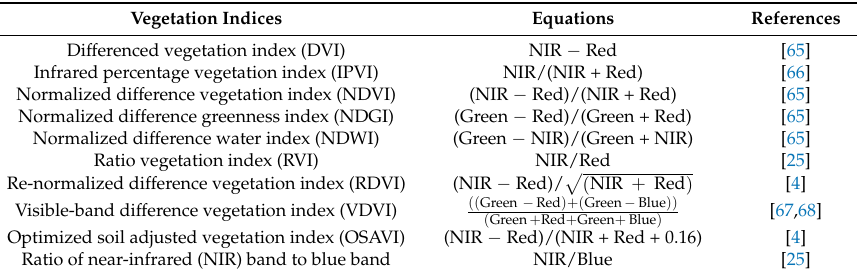
Table 2. Vegetation indices used in this